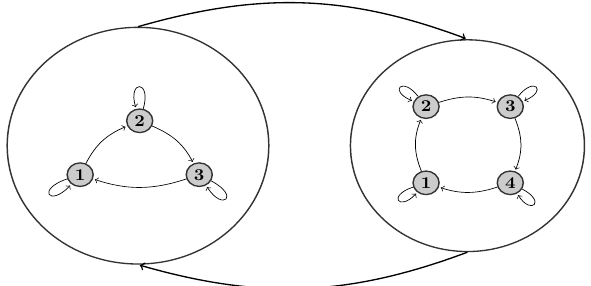
Figure 1. Topology of a two-level hierarchical hidden Markov model (hHMM). Large circles represent states in the first level of the model. Each state in turn is an HMM with sub-states (dark circles). Here, we applied left-to-right HMMs in the second